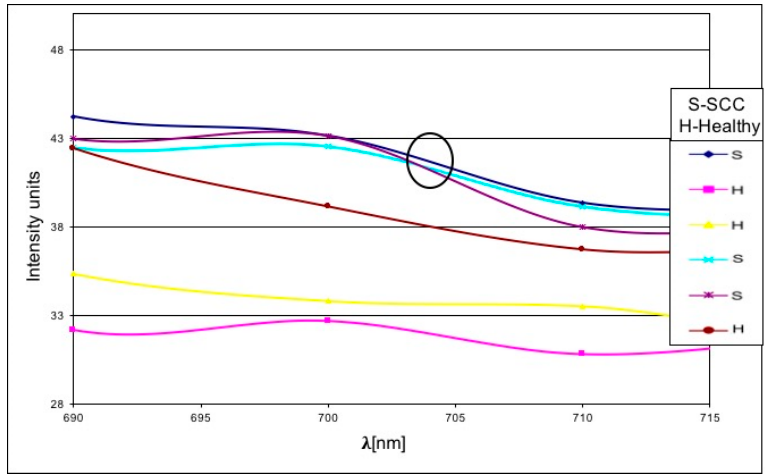
Figure 5. Reflectance spectra values in three tumor sites and three tumor-free sites. Focused view of second peak wavelength of the particle measured in the graph. Note the values in the area of the SCC.